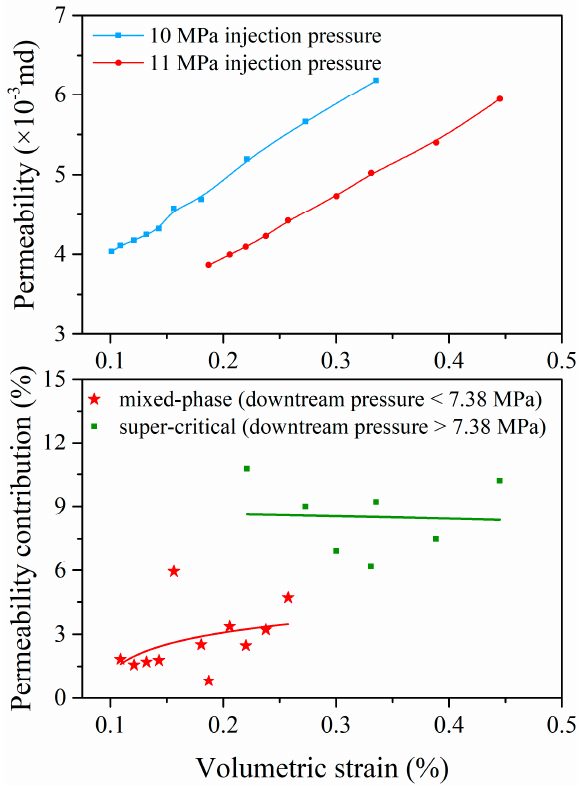
Figure 16. Mixed-phase CO 2 permeability and permeability contribution versus the volumetric strain.